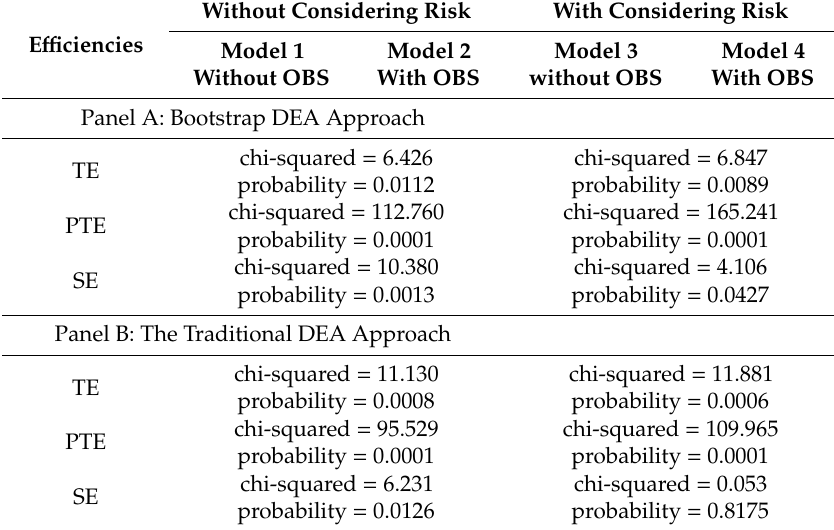
Table 5. Kruskal-Wallis test results for e ffi ciencies with and without o ff -balance sheet (OBS)